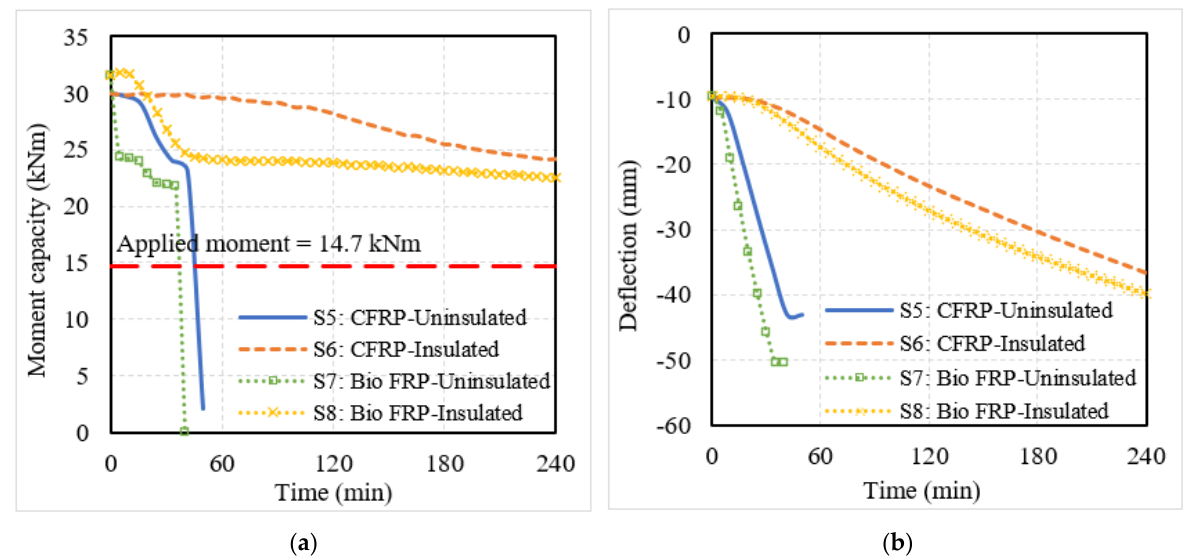
Figure 11. Structural response of slabs strengthened with conventional or bio-based EB FRP rein- forcement. ( a ) Moment capacity; ( b ) mid-span deflection.